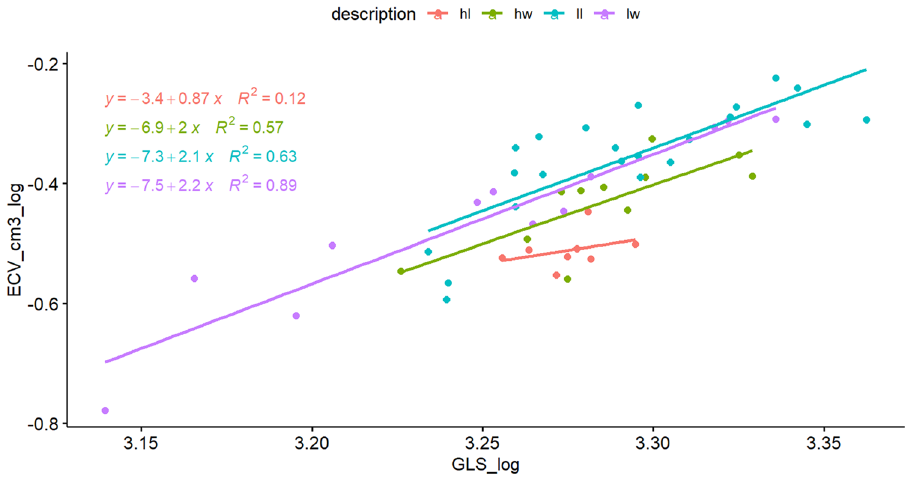
Figure 3. Analysis of co-variance showing regression slopes of log endocranial volume versus log skull length for high-elevation wild-caught (green) and lab-bred (red) and low-elevation wild-caught (purple) and lab-bred (blue) Peromyscus